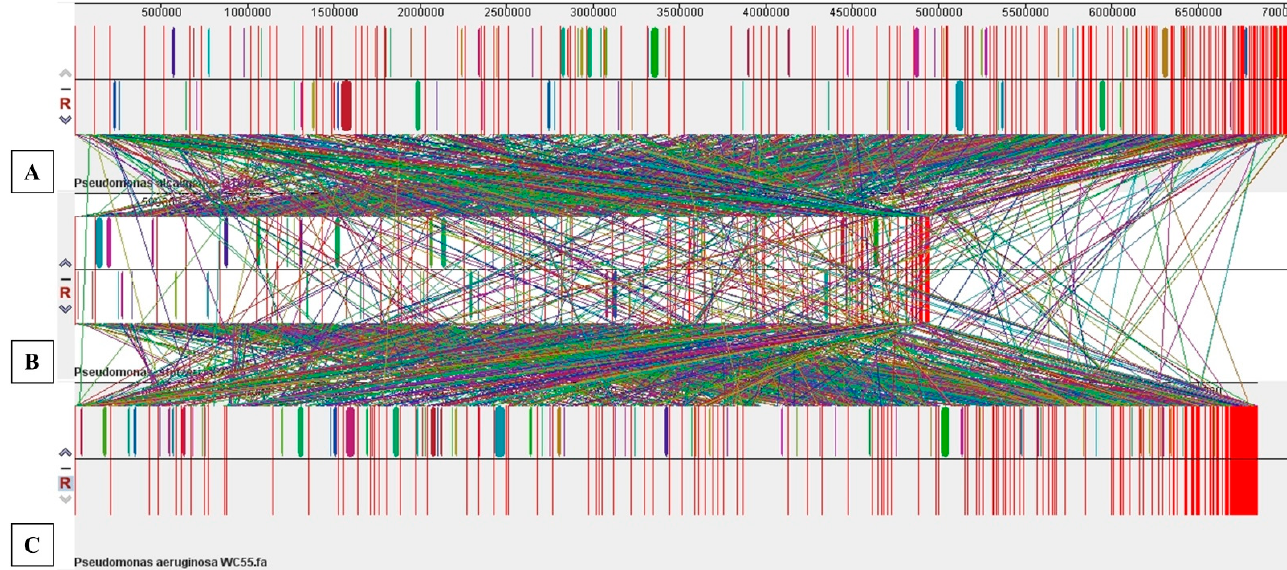
Figure 6. Whole genome comparative alignment of isolated Pseudomonas species using MAUVE analysis. Shown are ( A ), Pseudomonas alcaligenes OT69; ( B ), Pseudomonas stutzeri MF28 and ( C ), Pseudomonas aeruginosa WC55, respectively. Each of the genome sequence analyzed is presented horizontally with the scale showing the sequence coordinates and the conserved segments represented as the colored blocks which are connected across genomes. Blocks that are shifted downward in a genome represent those segments that are inverted relative to the reference genomes. The aligned region is in the forward orientation relative to the first genome sequence if a block lies above the center line; blocks below the center line indicate regions that align in the reverse complement (inverse) orientation of the reference genome. Genomic regions falling outside the blocks lack a detectable homology among the genomes analyzed. Within each block is shown the similarity profile of the genome sequence such that the height of the similarity profile corresponds to the level of conservation in that specific region of the genome. White areas represent those genomic regions that did not align well between the input genomes and likely contain sequence elements specific to a particular genome.